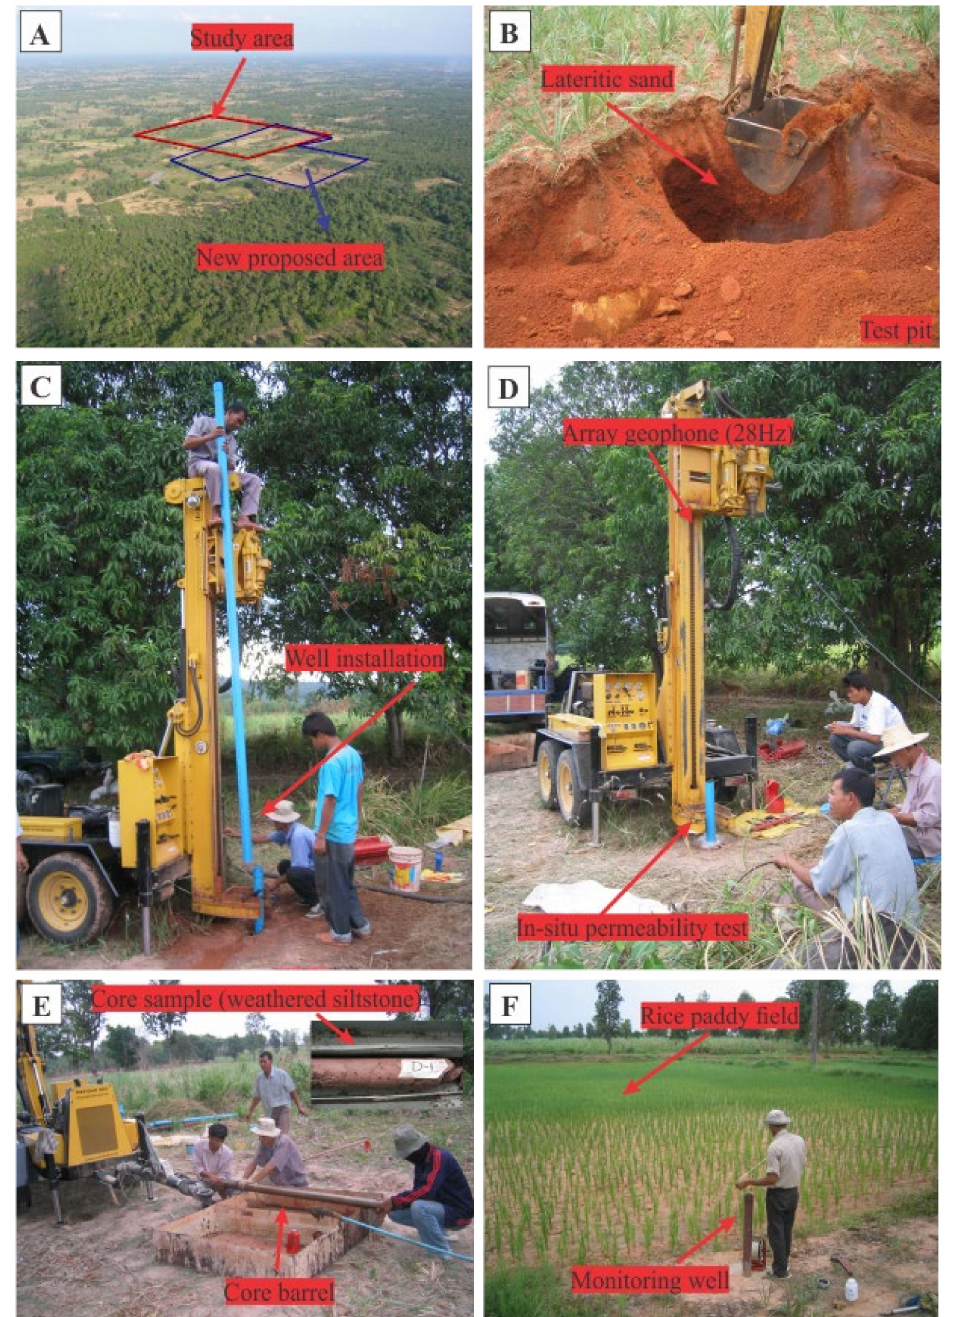
Figure 4. Aerial photos of the study area ( A ), test pit ( B ), monitoring well installation ( C ), in situ permeability test ( D ), core sample collection ( E ), and groundwater sampling in the study area ( F